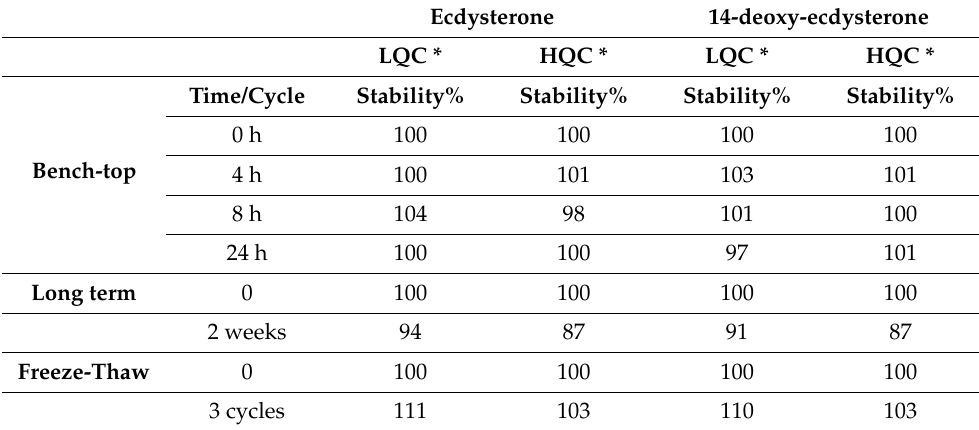
Table 4. Evaluation of the stability of ecdysterone and